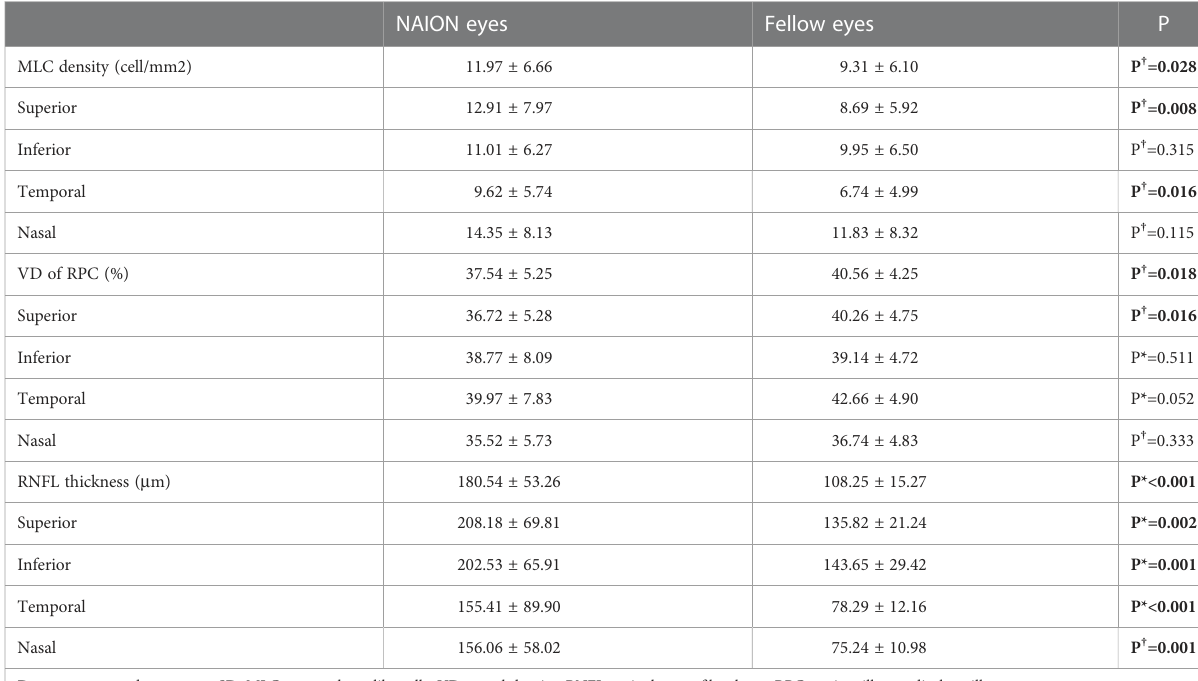
TABLE 2 Parameters of NAION eyes and the control